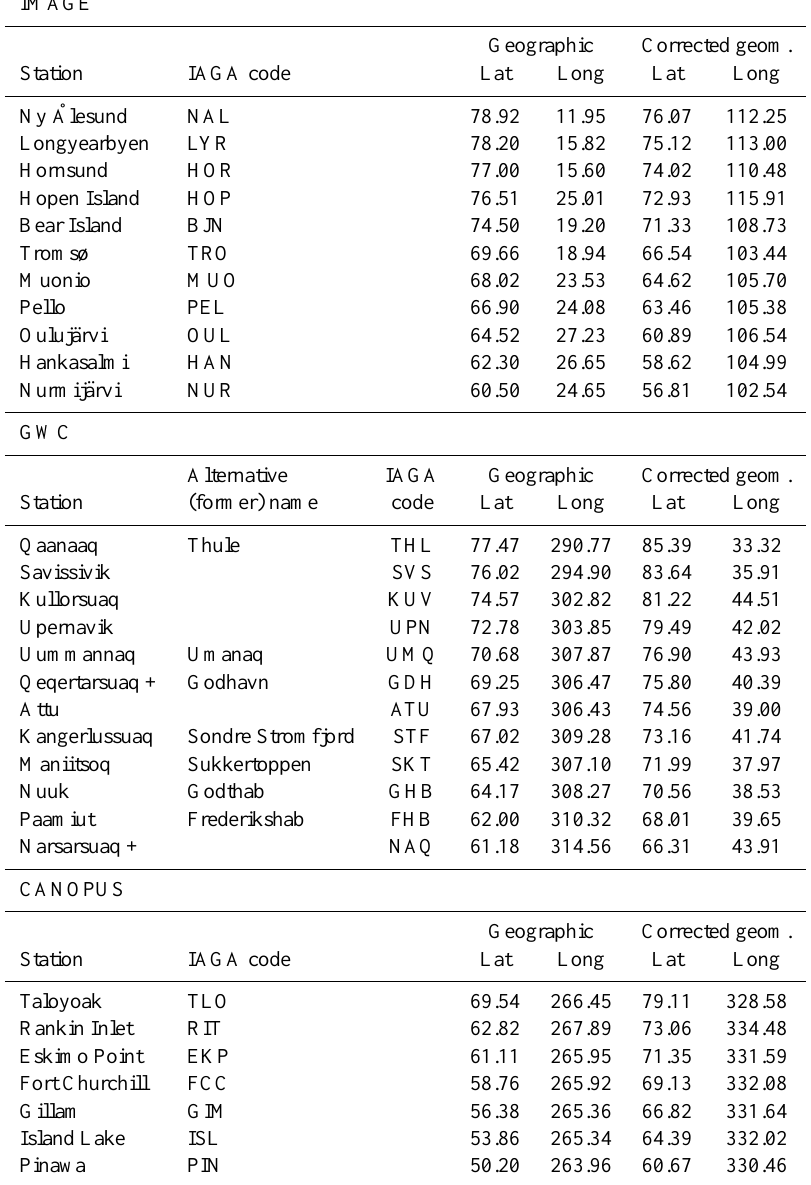
Table 1. High-latitude stations of three magnetometer chains for the epoch 1998. Geographic and corrected geomagnetic latitudes (Lat) and longitudes (Long) are also